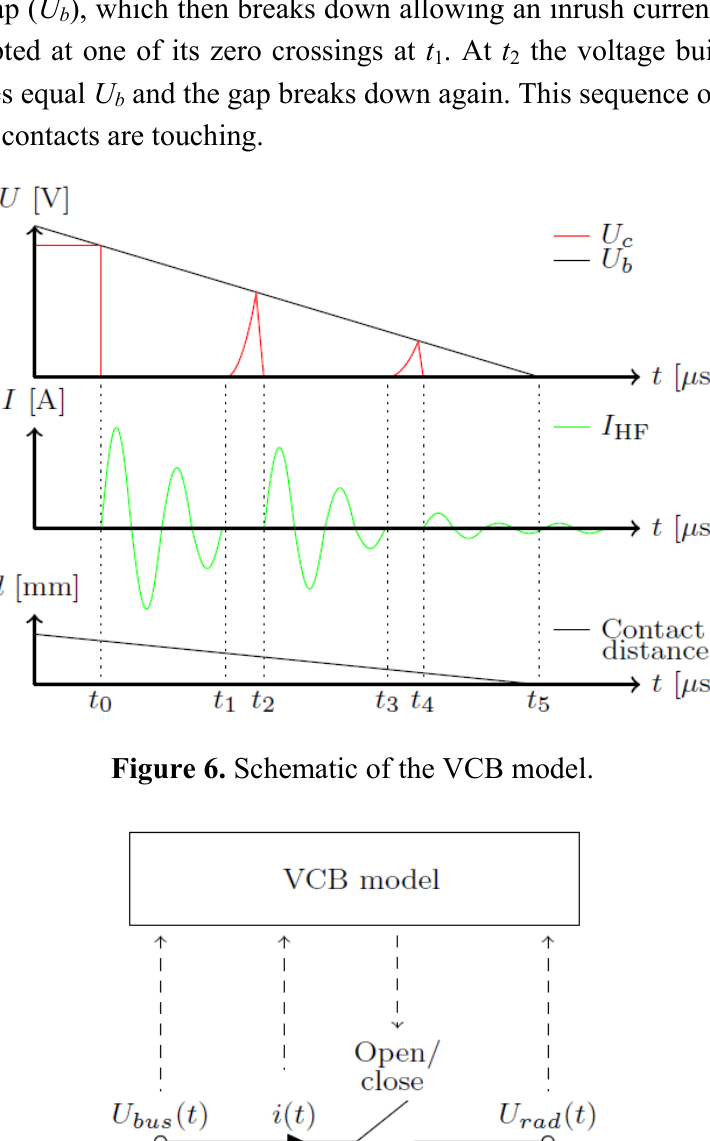
Figure 5. Schematic of multiple prestrikes during the VCB closing operation. At time